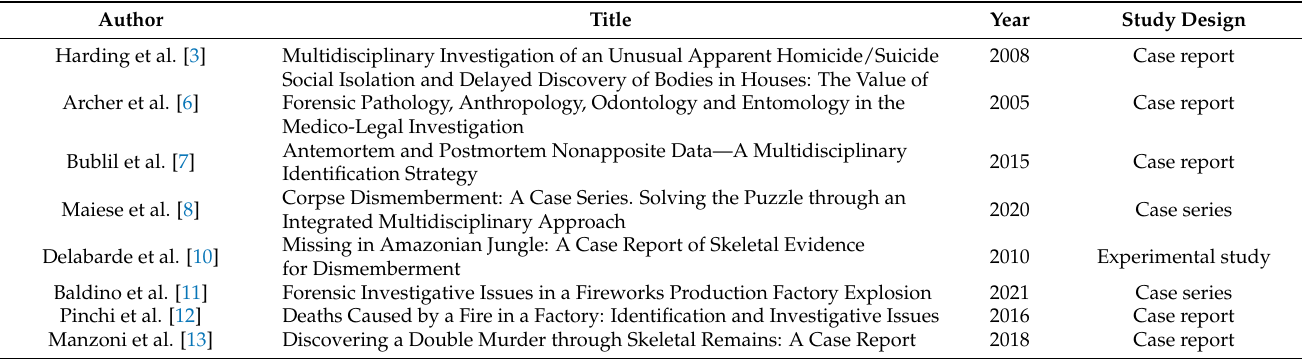
Table 1. Articles included in the revision; first author, reference, title, publication year and article type were schematically